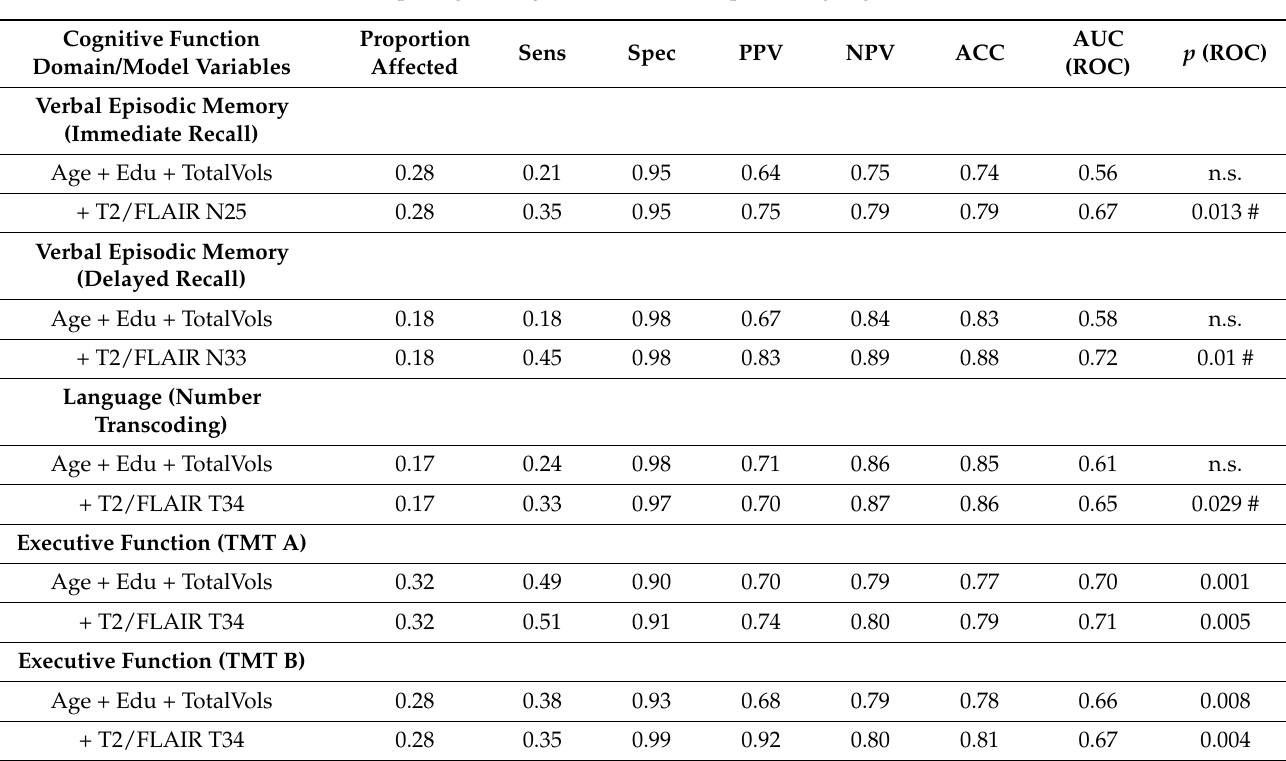
Table 2. Multiple logistic regression models for predicting cognitive